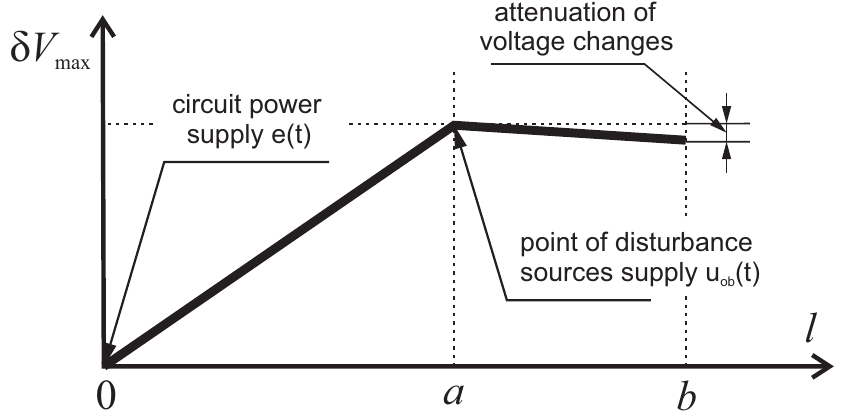
Figure 4. Linear approximation of the dependence δ V m ax = f ( l )